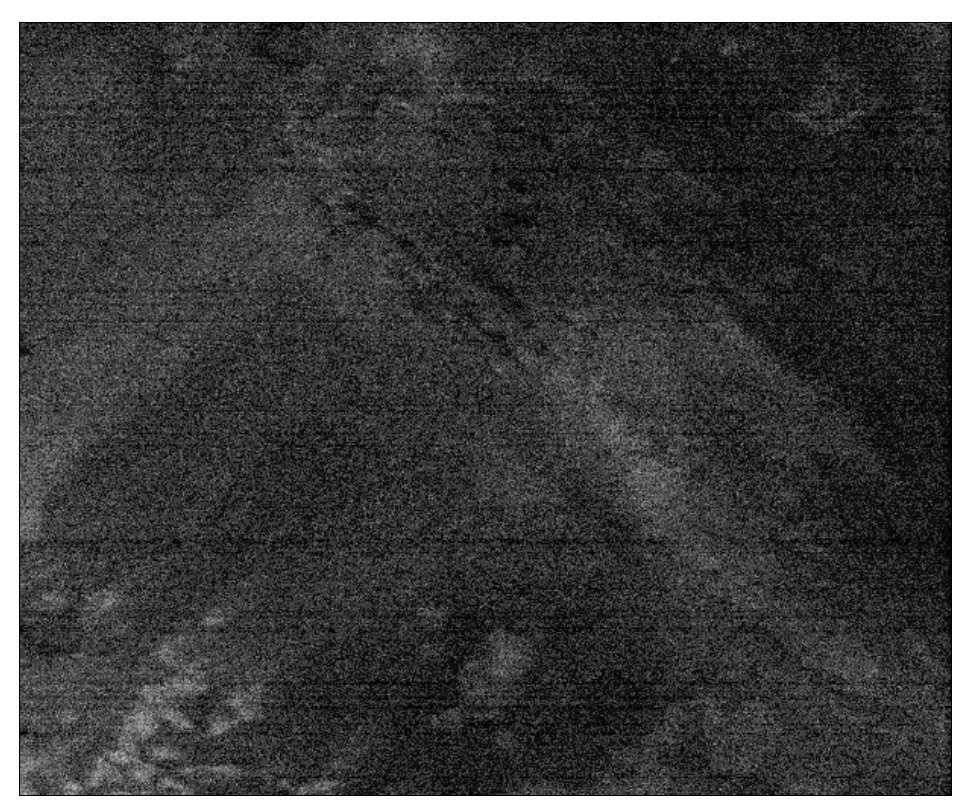
Figure 9. Lunar Lake Scene 01, Band